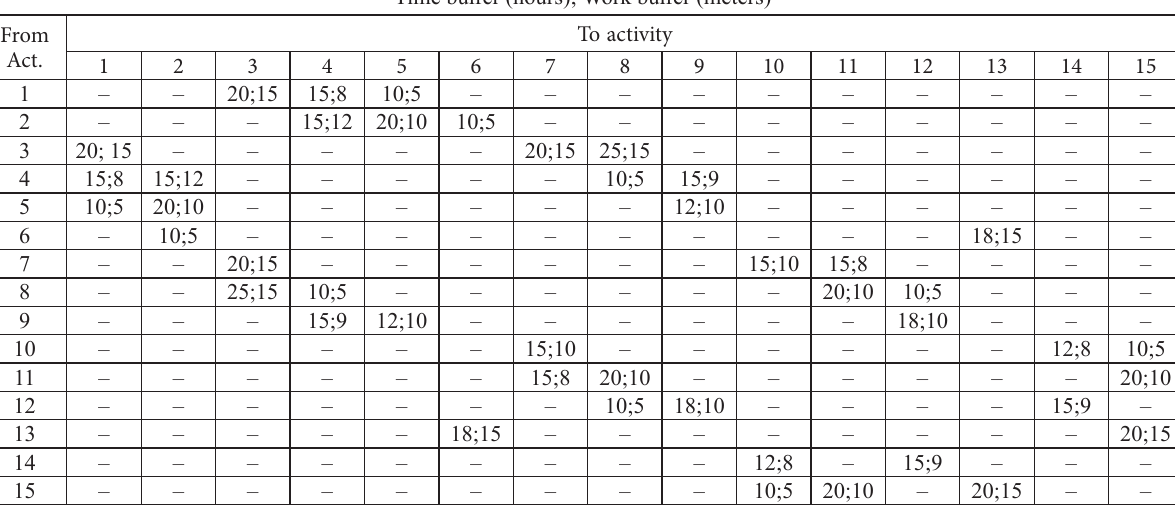
Table 2b. Time and work buffer data – case